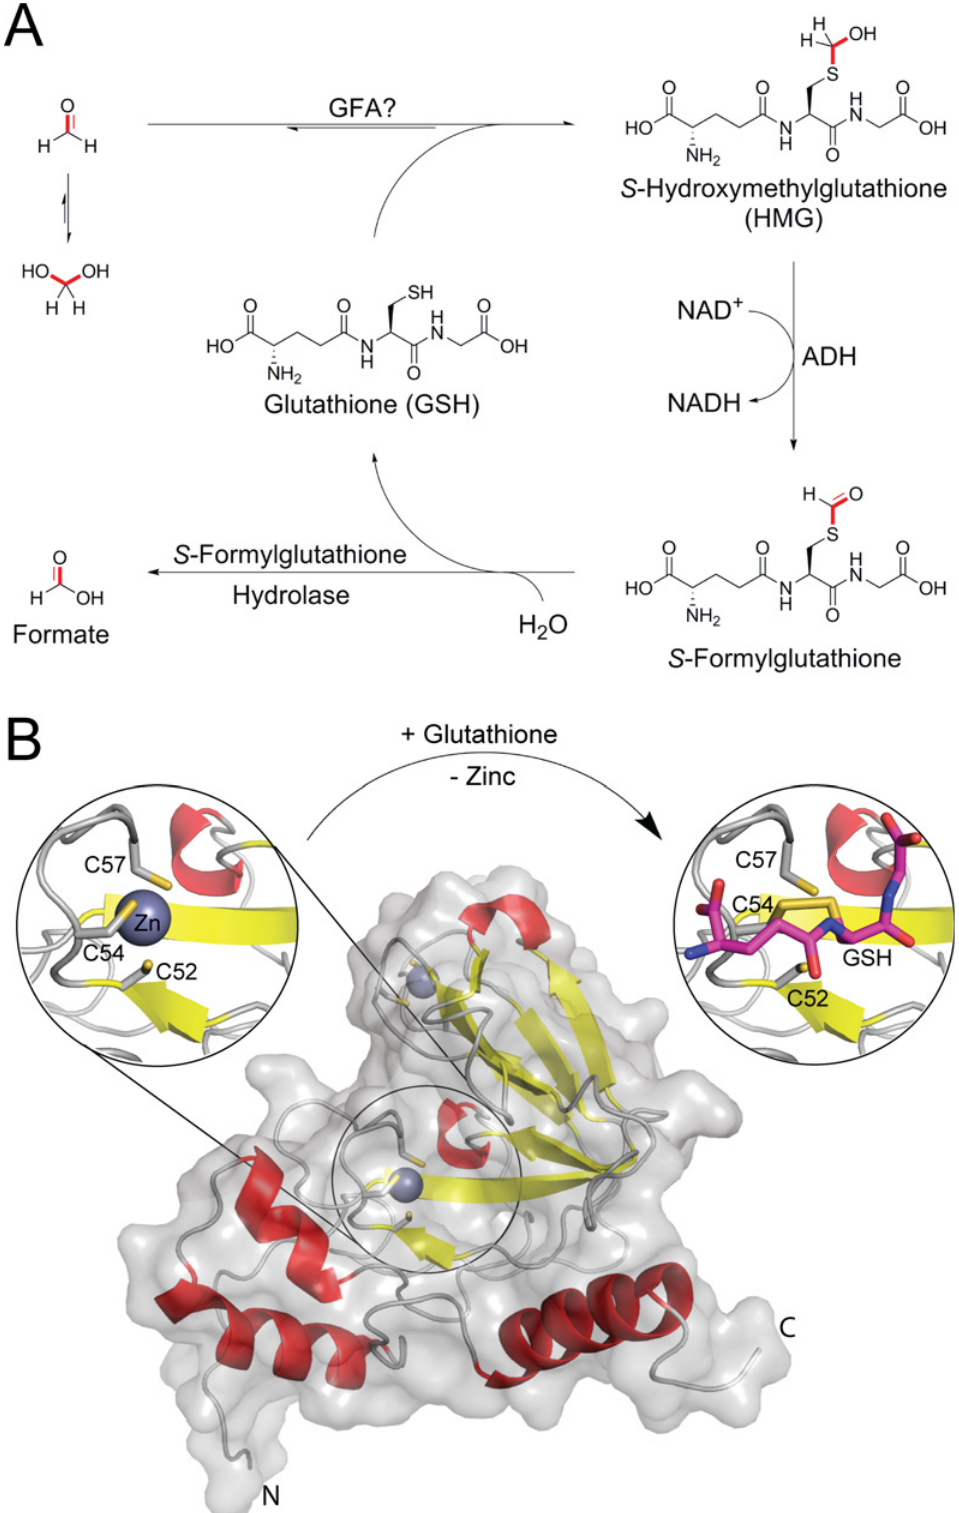
Fig 1. Overview of glutathione-dependent formaldehyde metabolism. (A) Summary scheme of glutathione-dependent formaldehyde metabolism. Formaldehyde (HCHO) reacts with glutathione (GSH) via its nucleophilic thiol group to form S -hydroxymethylglutathione (HMG), which is a substrate of